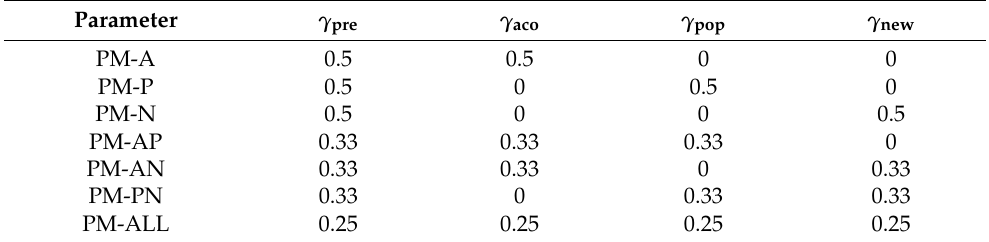
Table 1. PM-based models and each parameter value of the reward function R t